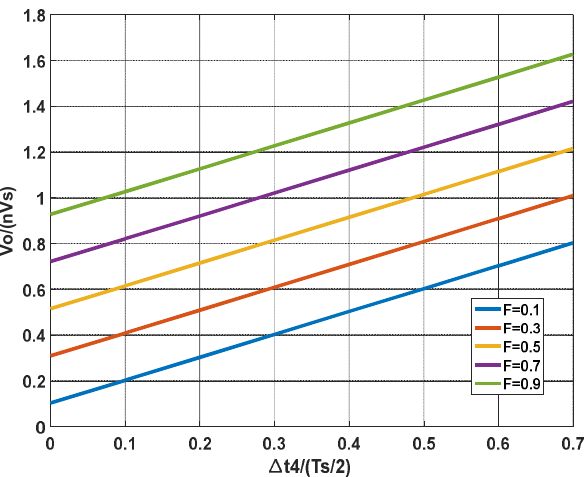
Figure 6. Three-dimensional (3D) plot of the voltage gain, M , of the proposed converter when is constant.